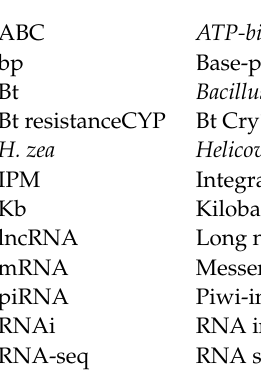
Figure S2: Sequence length distributions for all putative lncRNA transcripts in Cry1Ac resistant H. zea. Figure S3A–D: All upregulated lncRNA and coding gene proximities examined, Figure S4A–C: All downregulated lncRNA and coding gene proximities examined, Figure S5: lncRNA found only in Bt-resistant strain and coding gene proximities, Figure S6: lncRNA found only in Bt-susceptible strain and coding gene proximities, Table S1: lncRNAs with increased expression in Cry1Ac resistant bollworms where log2 fold change could be calculated. Table S2: lncRNAs with decreased expression in Cry1Ac resistant bollworms where log2 fold change could be calculated. Table S3: lncRNAs unique to either the Cry1Ac resistant or susceptible strains that had no log2 fold change. Table S4: lncRNA to coding gene BLASTn comparisons in pseudogene